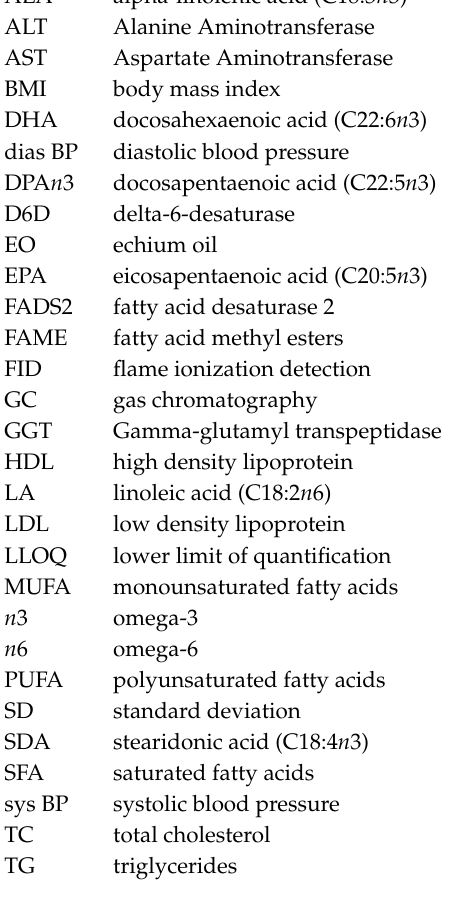
Table S1: Daily energy, macronutrient and fatty acid intake of study participants during the whole period of the standardized nutrition (Day 1, 2 and 3) (A) and energy, macronutrient and fatty acid intake of meals at Day 1 of the standardized nutrition (B), Table S2: Fatty acid pattern in plasma after single-dose ingestion of echium